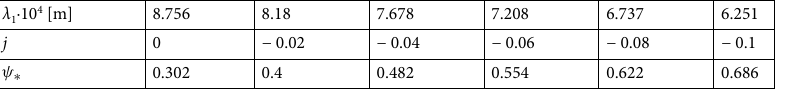
Table 1. Interdendritic spacing (cid:31) 1 at various melt fluxes j accordingly to expressions (32) and (33).